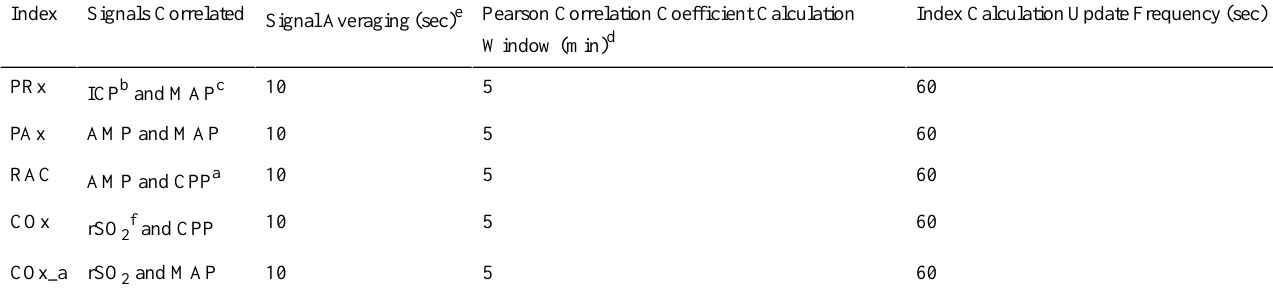
Table 1. Continuous cerebrovascular reactivity indices to be derived.